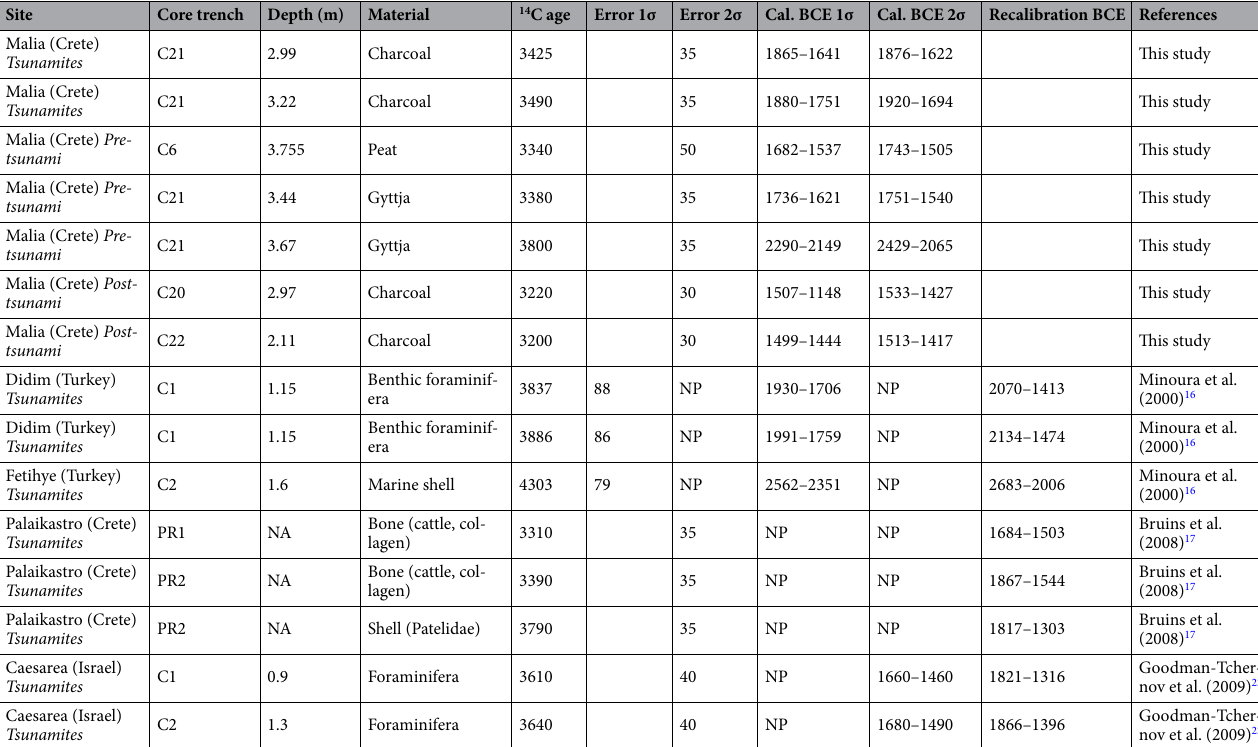
Table 1. Radiocarbon dates of samples attributed to the Minoan tsunami deposits in their chronological context in Malia (pre- and post-tsunami) and in the wider Eastern Mediterranean. Calibrations or recalibrations are based on OxCal v4.3.2 and datasets IntCal-20 and Marine20 for foraminifera and marine shells (see “Supplementary Text”).